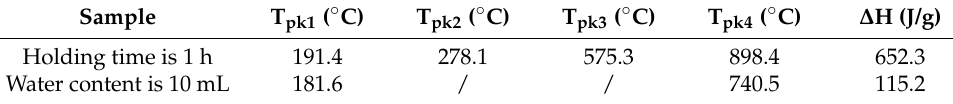
Figure 14. DSC plots for ( a ) a holding time of 1 h and ( b ) 10 mL of deionized water. Table 3. DSC parameters of the nanocomposite at different conditions in argon.